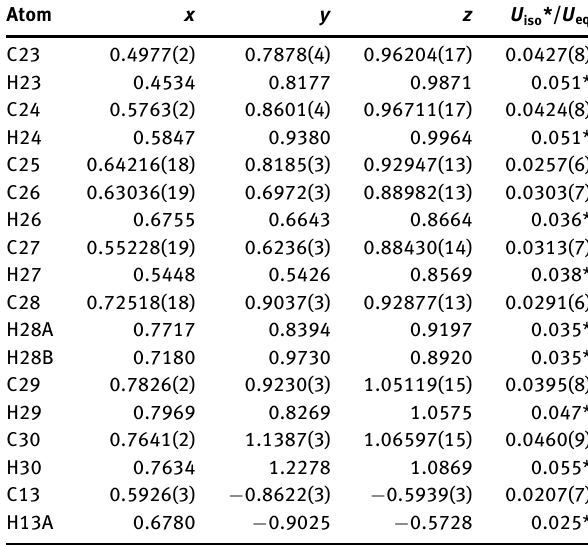
Table 2: Fractional atomic coordinates and isotropic or equivalent isotropic displacement parameters (Å 2